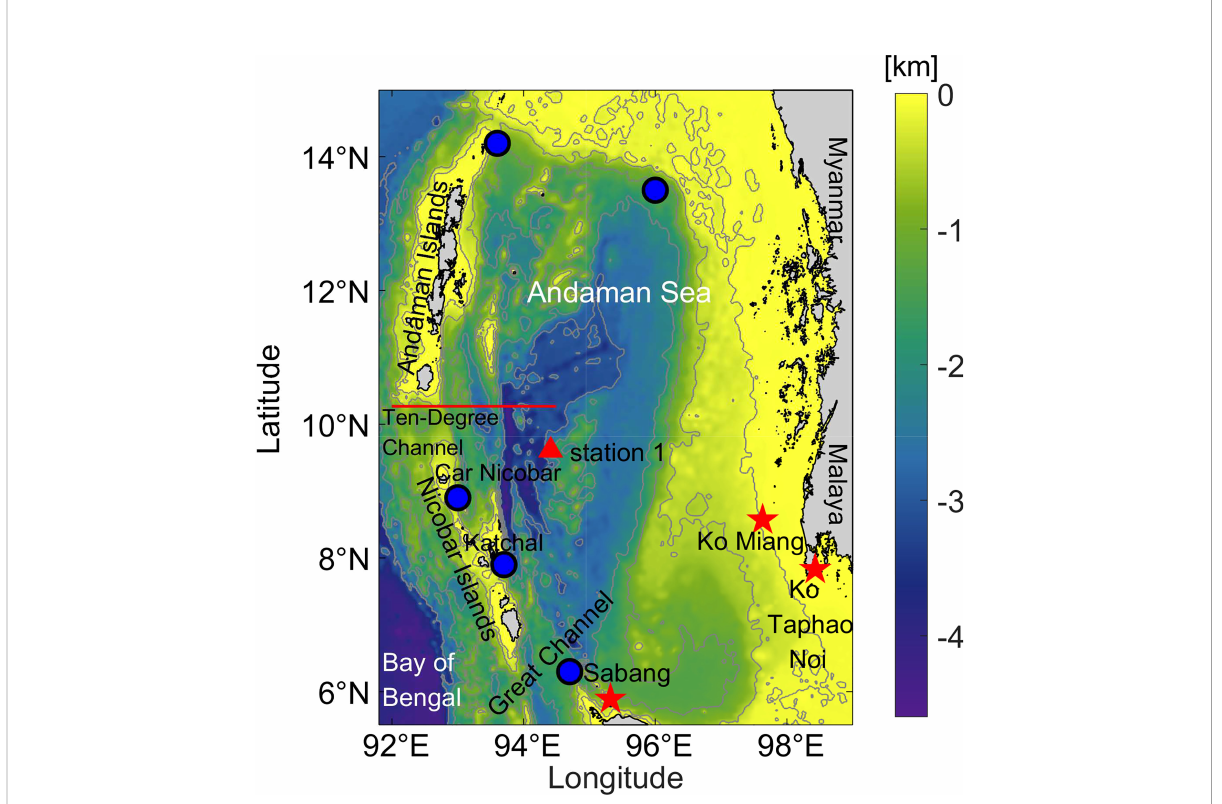
FIGURE 1 Bathymetry map of the model domain. Bathymetry contours are spaced at 100, 500, 1200, 2000, and 3000 m. The red stars represent the three observed stations in the Andaman Sea. The red line indicates one of the major paths of internal tides in the Andaman Sea. The red triangle illustrates the selected section to show the internal tidal form. The blue circles denote the potential generation regions of internal tides (Raju et al.,